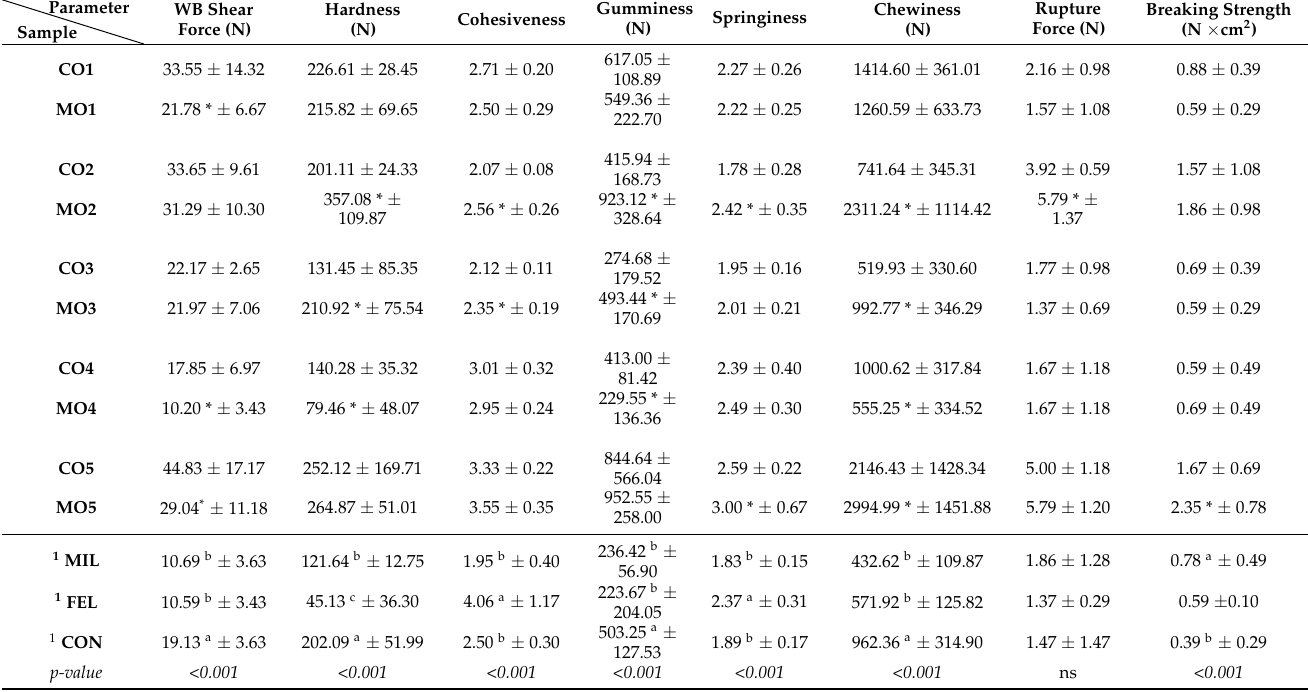
vs. MO4. The main differences were found between CO2 vs. MO2, CO3 vs. MO3, and CO5 vs. MO5. Table 5. Mean values of textural parameters assessed in salami manufactured from pigs belonging to conventional or Mora Romagnola breeds. Samples were coded as CO1 (conventional salami with small size), MO1 (Mora Romagnola salami with the same size as CO1), CO2 (conventional salami of “Nostrano” type), MO2 (Mora Romagnola salami similar to CO2), CO3 (conventional salami of “Cacciatore” type), MO3 (Mora Romagnola salami similar to CO3), CO4 (conventional salami obtained directly from a local producer), MO4 (Mora Romagnola salami similar to CO4), CO5 (conventional salami obtained directly from a local producer), MO5 (Mora Romagnola salami similar to CO5), CON (conventional salami of “Contadino” type), FEL (conventional salami of “Felino” (PGI) type), and MIL (conventional salami of “Milano”